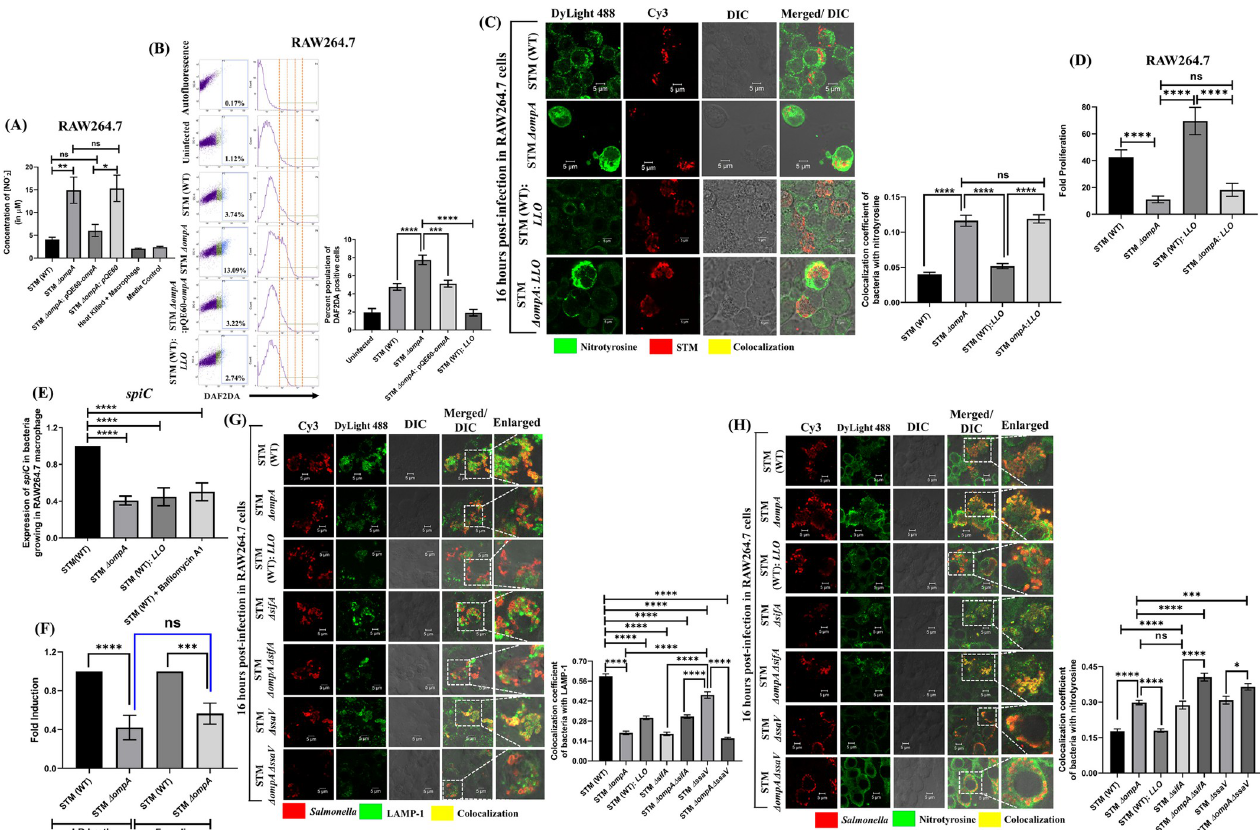
Fig 3. In addition to sifA and ssaV , Salmonella uses OmpA to combat the nitrosative stress of macrophages. (A) Estimating the extracellular nitrite from the culture supernatant of RAW264.7 cells infected with STM (WT), Δ ompA , Δ ompA : pQE60- ompA , Δ ompA : pQE60, & heat-killed bacteria (MOI = 10) respectively by Griess assay (n = 3, N = 5). (B) Representative dot plots (SSC-A vs. DAF-2 DA) and histograms (Count vs. DAF-2 DA) of RAW264.7 cells infected with STM (WT), Δ ompA , Δ ompA : pQE60- ompA , and (WT): LLO (MOI 10) to estimate the level of intracellular nitric oxide (NO) using DAF-2 DA (5 μ M). The percent population of DAF-2 DA positive cells was represented in a vertical bar graph (n � 3, N = 6). (C) Immunofluorescence image of RAW264.7 cells infected with STM (WT), Δ ompA , (WT): LLO , and Δ ompA : LLO at MOI 20. The colocalization coefficient of bacteria with nitrotyrosine was represented as a vertical bar graph. Scale bar = 5 μ m (n = 50, N = 3). (D) Fold proliferation of STM (WT), Δ ompA , (WT): LLO , and Δ ompA : LLO in RAW264.7 cells (n � 3, N = 2). (E) Quantifying the transcript-level expression of spiC from RAW264.7 cells infected with STM (WT), Δ ompA & (WT): LLO at MOI 50. STM (WT) infected RAW264.7 cells treated with bafilomycin A (50 nM) were used as a control (n = 3, N = 3). (F) Estimating the expression of spiC by RT-qPCR in STM (WT) and Δ ompA growing in LB broth and acidic F media (n = 3, N = 5). (G) Representative image of LAMP-1 recruitment on STM (WT), Δ ompA , (WT): LLO , Δ sifA , Δ ompA Δ sifA , Δ ssaV , Δ ompA Δ ssaV (MOI = 20) in RAW264.7 cells. The colocalization coefficient of the bacteria with LAMP-1 was represented as a vertical bar graph. Scale bar = 5 μ m (n = 80, N = 3). (H) Representative image of RAW264.7 cells infected with STM (WT), Δ ompA , (WT): LLO , Δ sifA , Δ ompA Δ sifA , Δ ssaV , Δ ompA Δ ssaV (MOI = 20) to visualize the recruitment of nitrotyrosine on the bacteria. The vertical bar graph depicts the colocalization coefficient of bacteria with intracellular nitrotyrosine. Scale bar = 5 μ m, (n = 100, N = 3). Data are represented as mean ± SEM. (P) � < 0.05, (P) �� < 0.005, (P) ��� < 0.0005, (P) ���� < 0.0001, ns = non-significant, (One-way ANOVA)